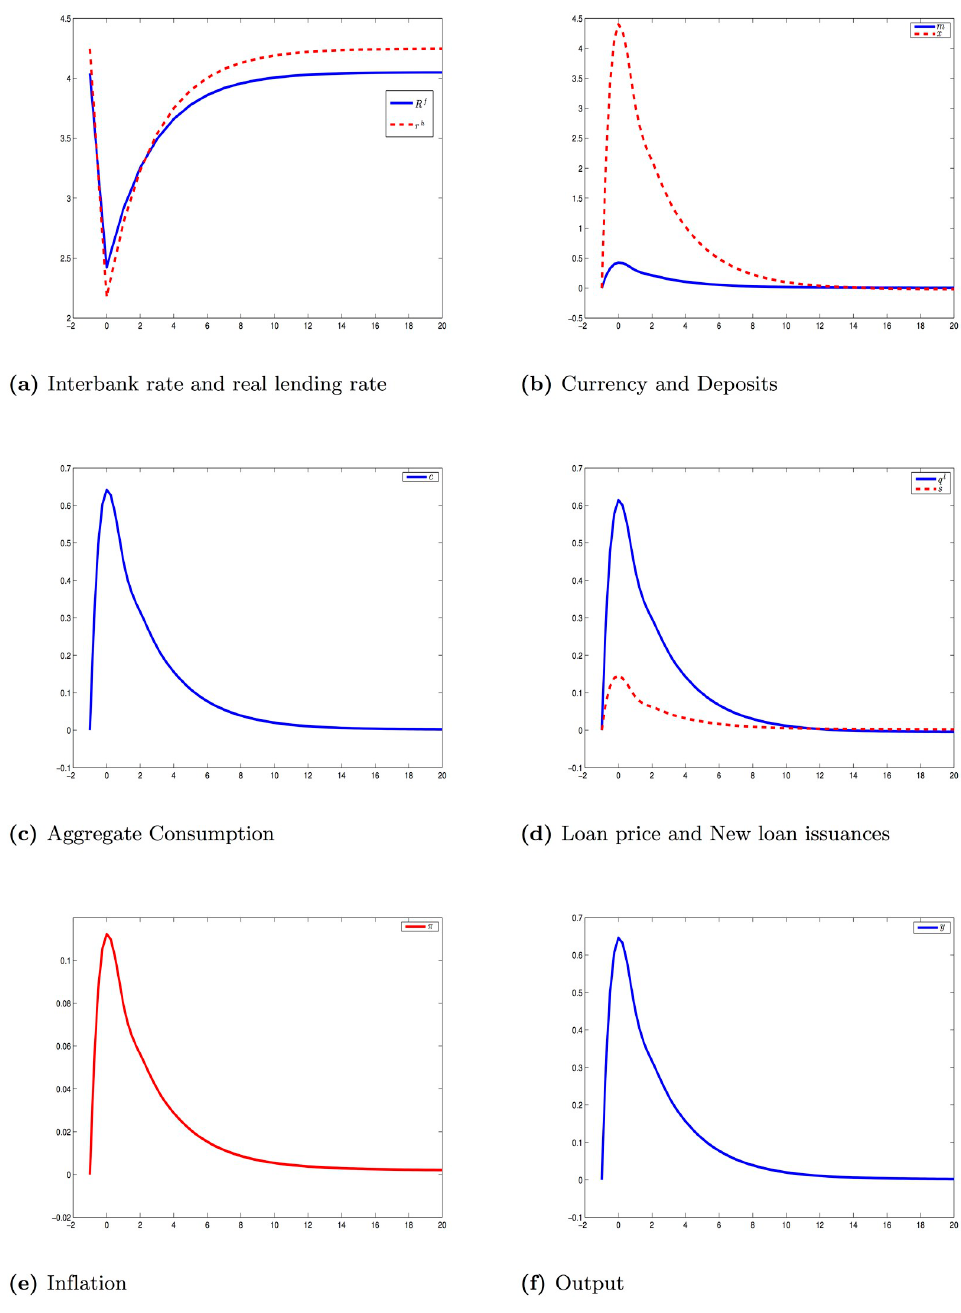
Fig 1. Impulse response to interest rate shock (M1).